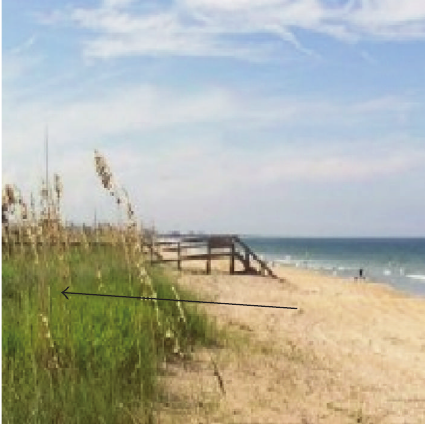
Figure 1: Natural images often do not have clear-cut “hard” bound- aries between di ff erent patterns. Along the arrow, for example, one only observes that the sand pattern gradually becomes a grass pat- tern. Such a “soft” view is the stochastic view on the segmentation